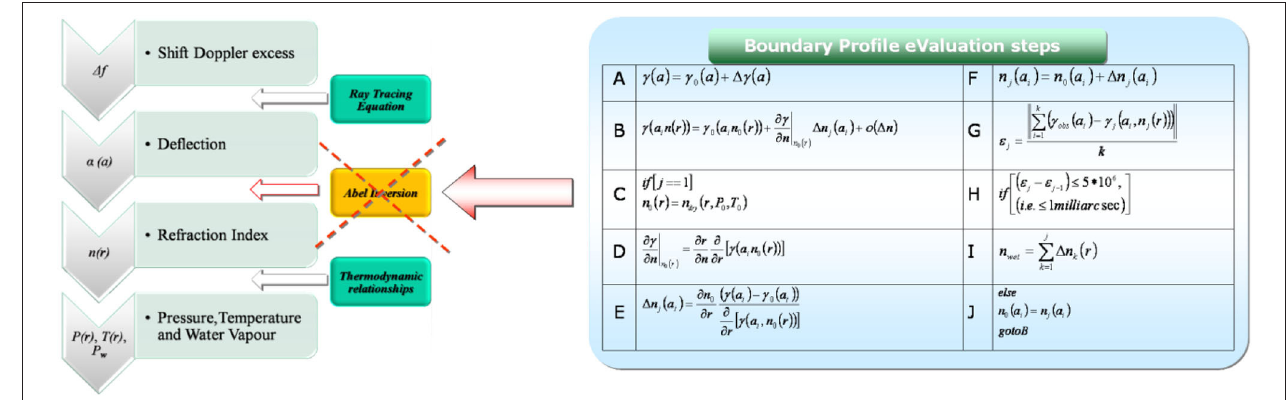
FIGURE 2 | A schematic description of the variational approach used by the BPV method in order to retrieve total refractivity. More details can be found in Vespe and Persia